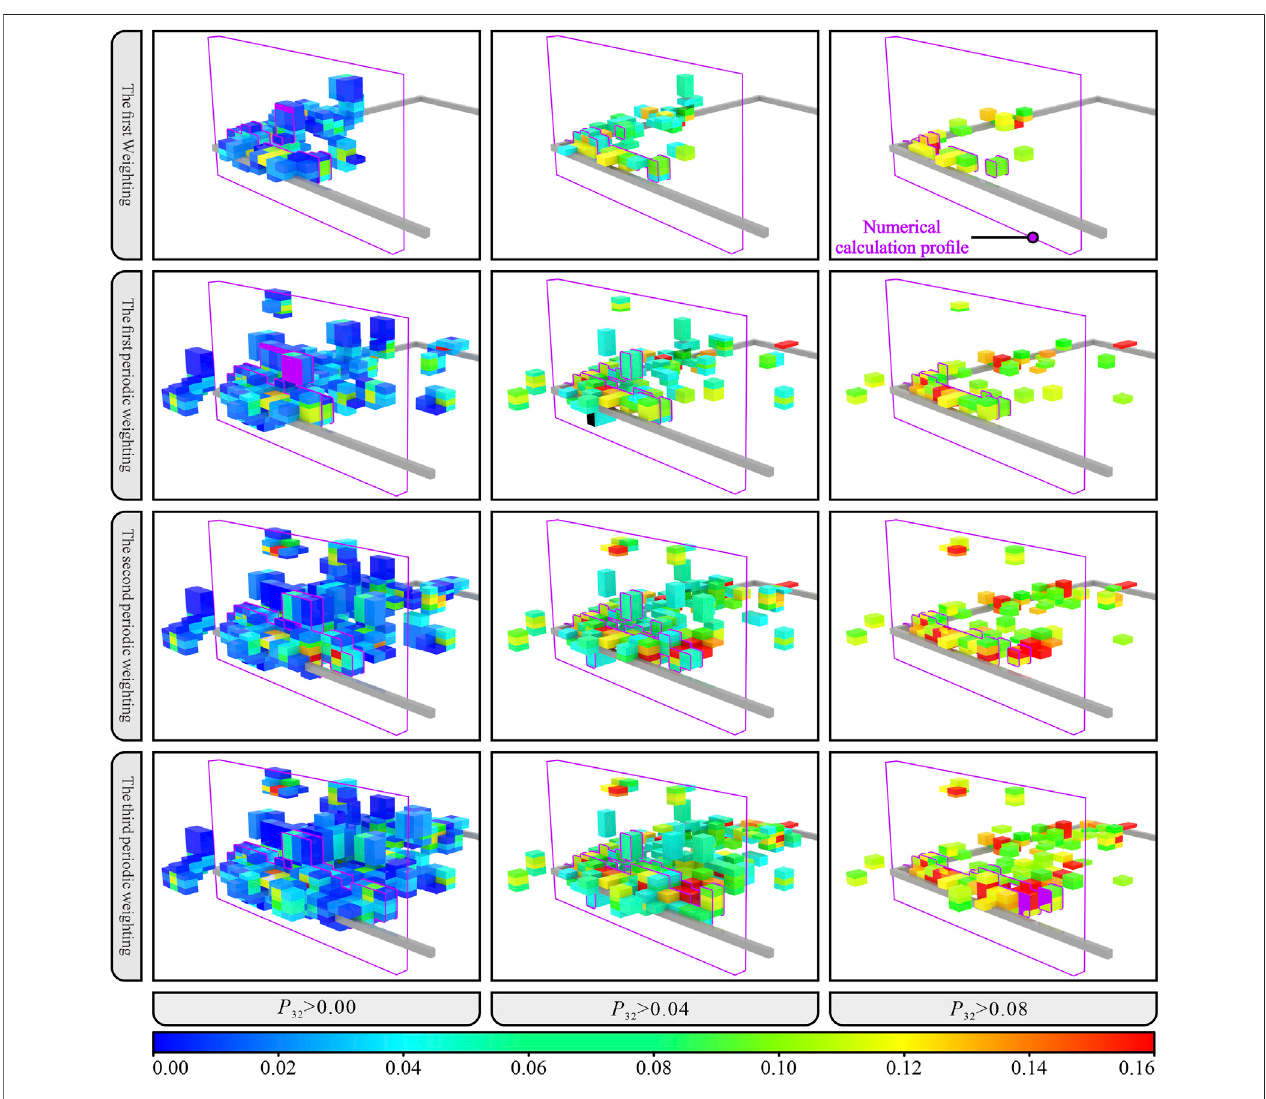
FIGURE 6 | Spatial and temporal evolution of P32 in No. 18401